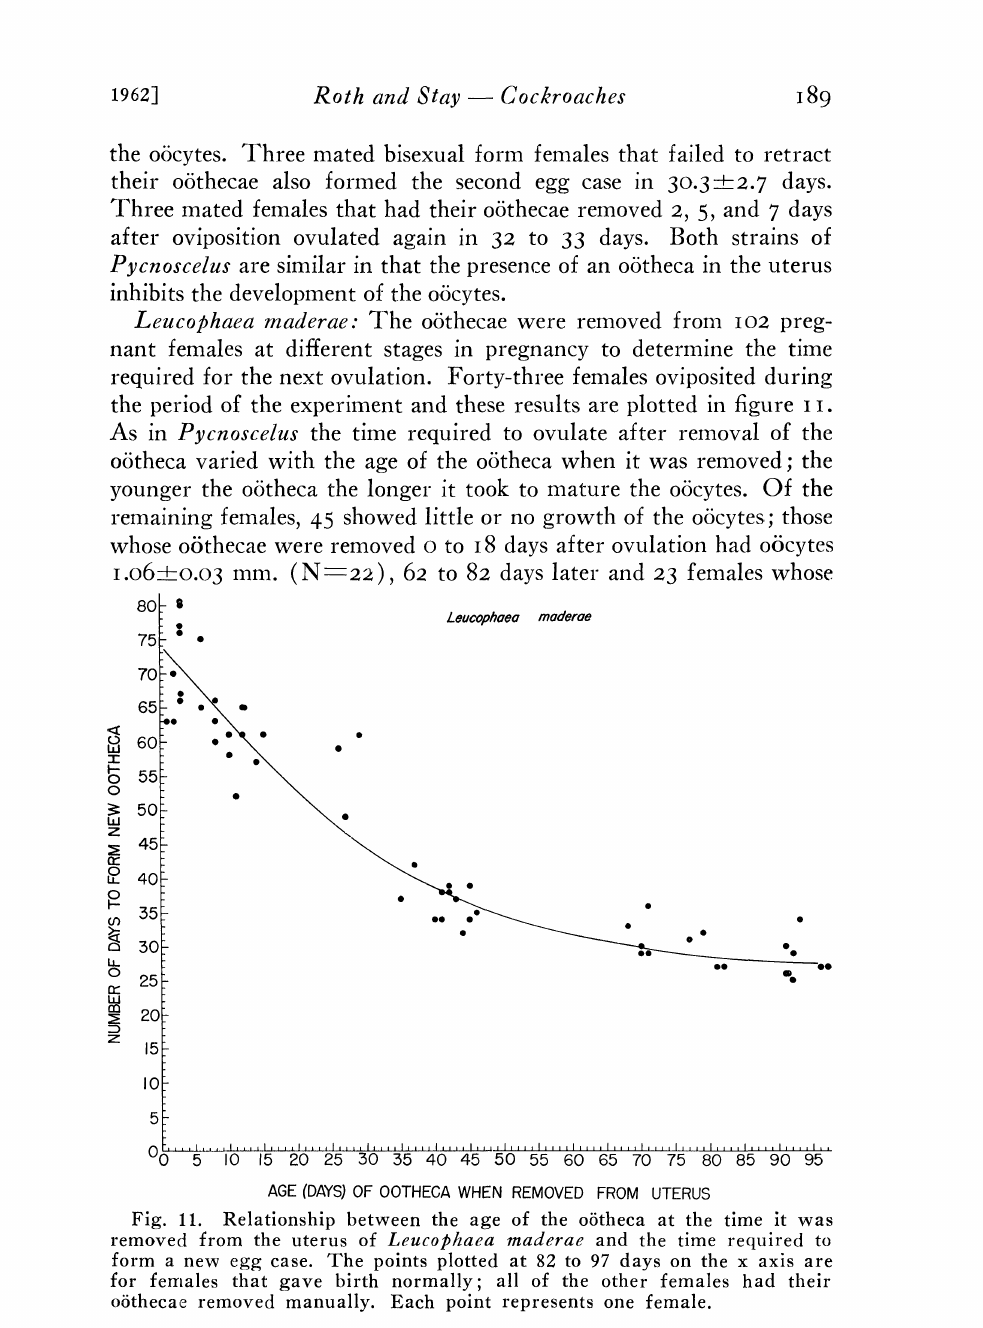
Fig. 11. Relationship between the age of the o6theca at the time it was removed from the uterus of Leucophaea maderae and the time required to form a new egg case. The points plotted at 82 to 97 days on the x axis are for females that gave birth normally; all of the other females had their otithecae removed manually. Each point represents one